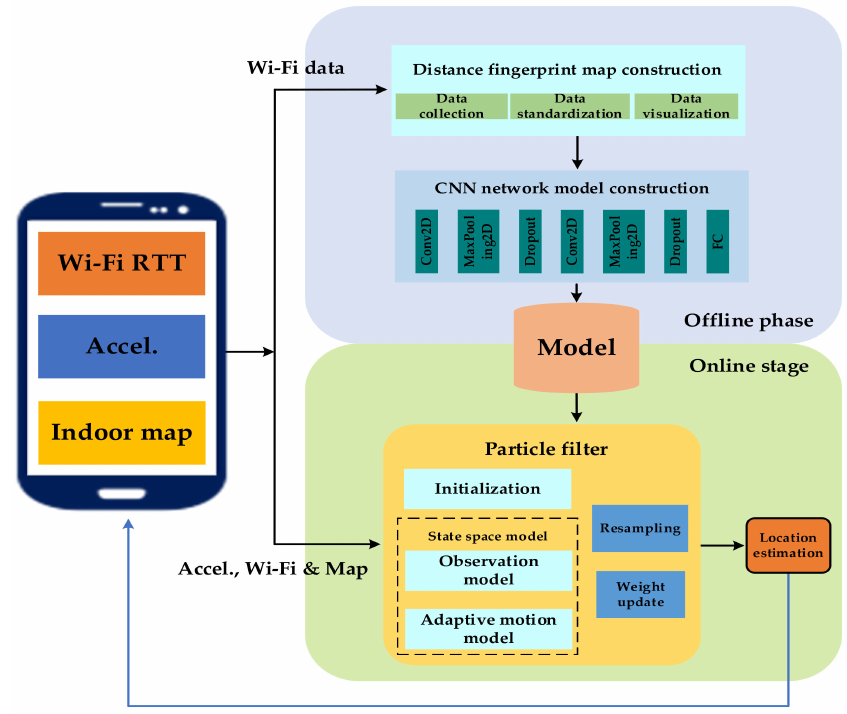
Figure 3. Structure diagram of high-precision indoor pedestrian positioning system